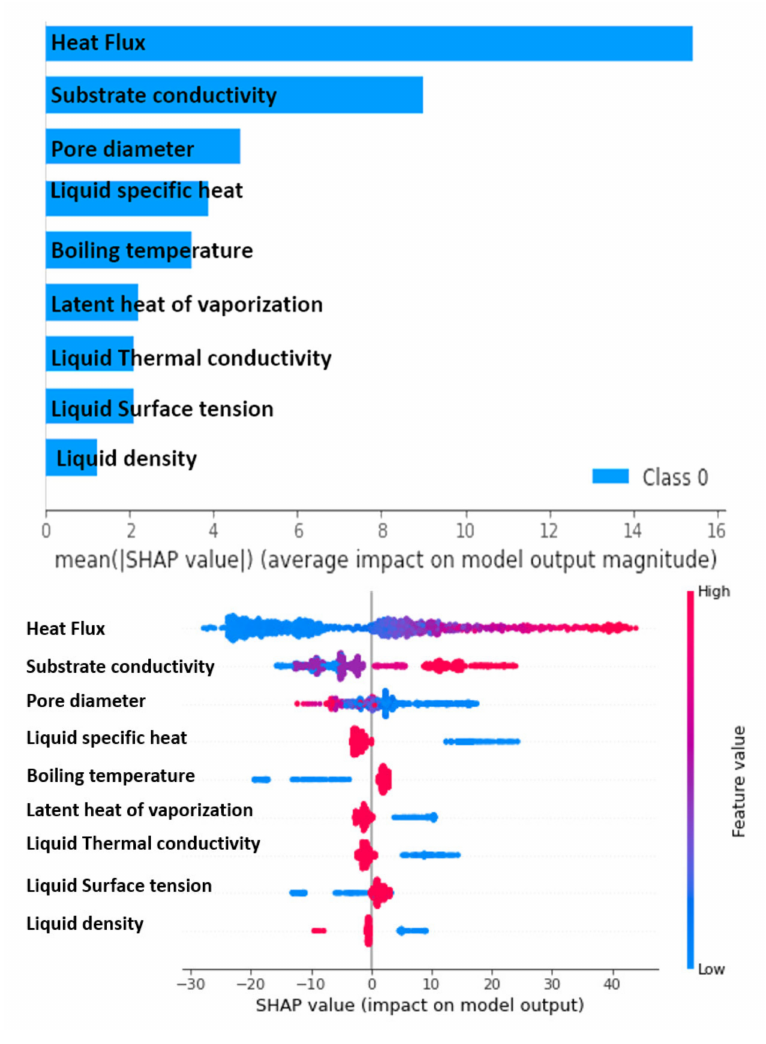
Figure 13. Sensitivity